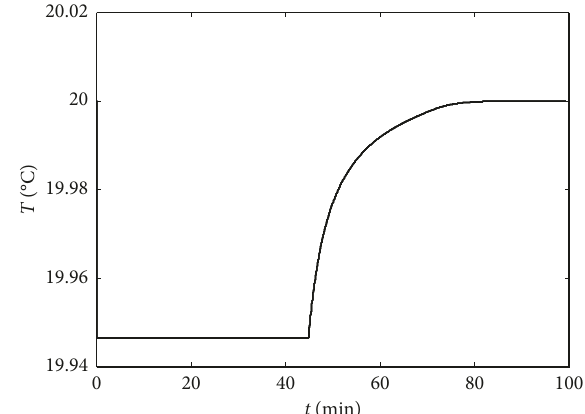
Figure 6: Isothermal drying: temporal evolution of temperature of the sphere particle (the temperature of the whole sample is the